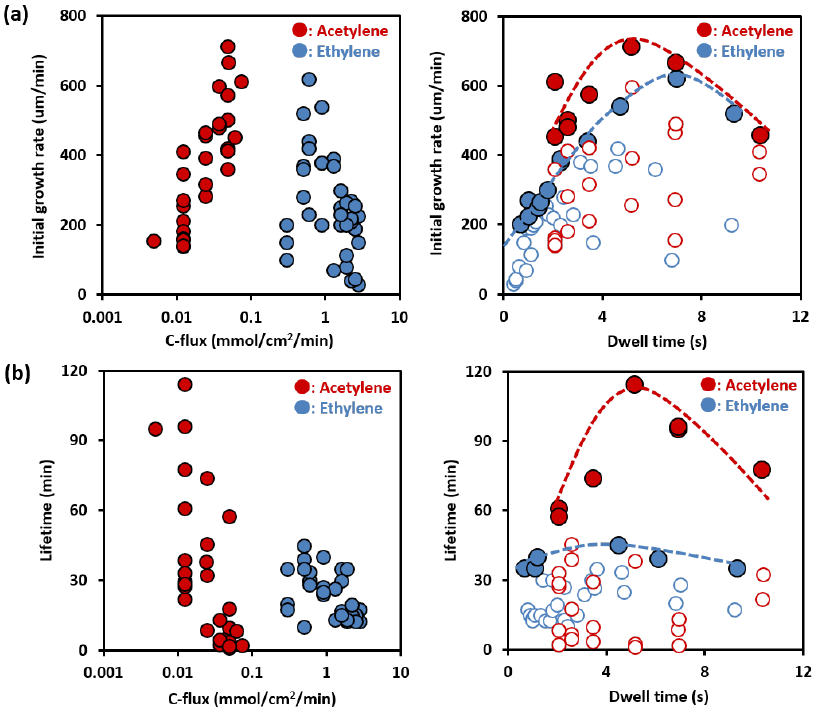
Figure 2. Two-dimensional mapping of ( a ) initial growth rate; and ( b ) life time as functions of dwell time and carbon flux. Blue and red circles show SWCNT growth using ethylene and acetylene, respectively. (Growth temperature: 1083 K of acetylene, 1073 K of ethylene, growth time: 10